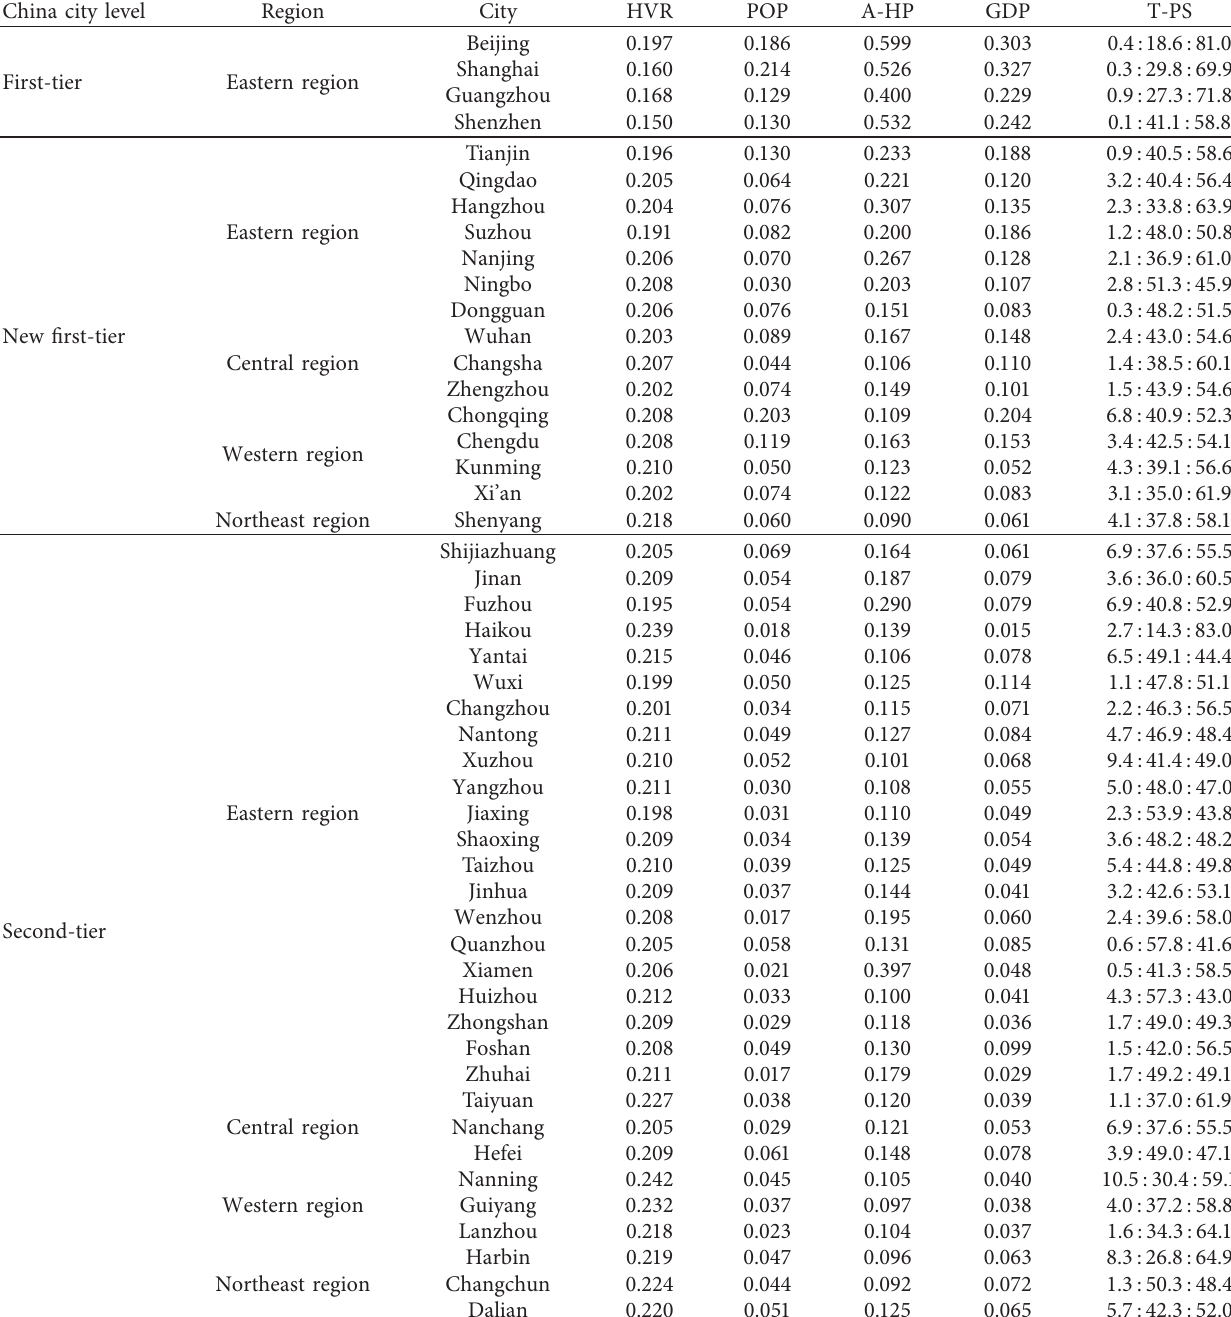
Table 3: HVR and standardized social factors in the cities of various